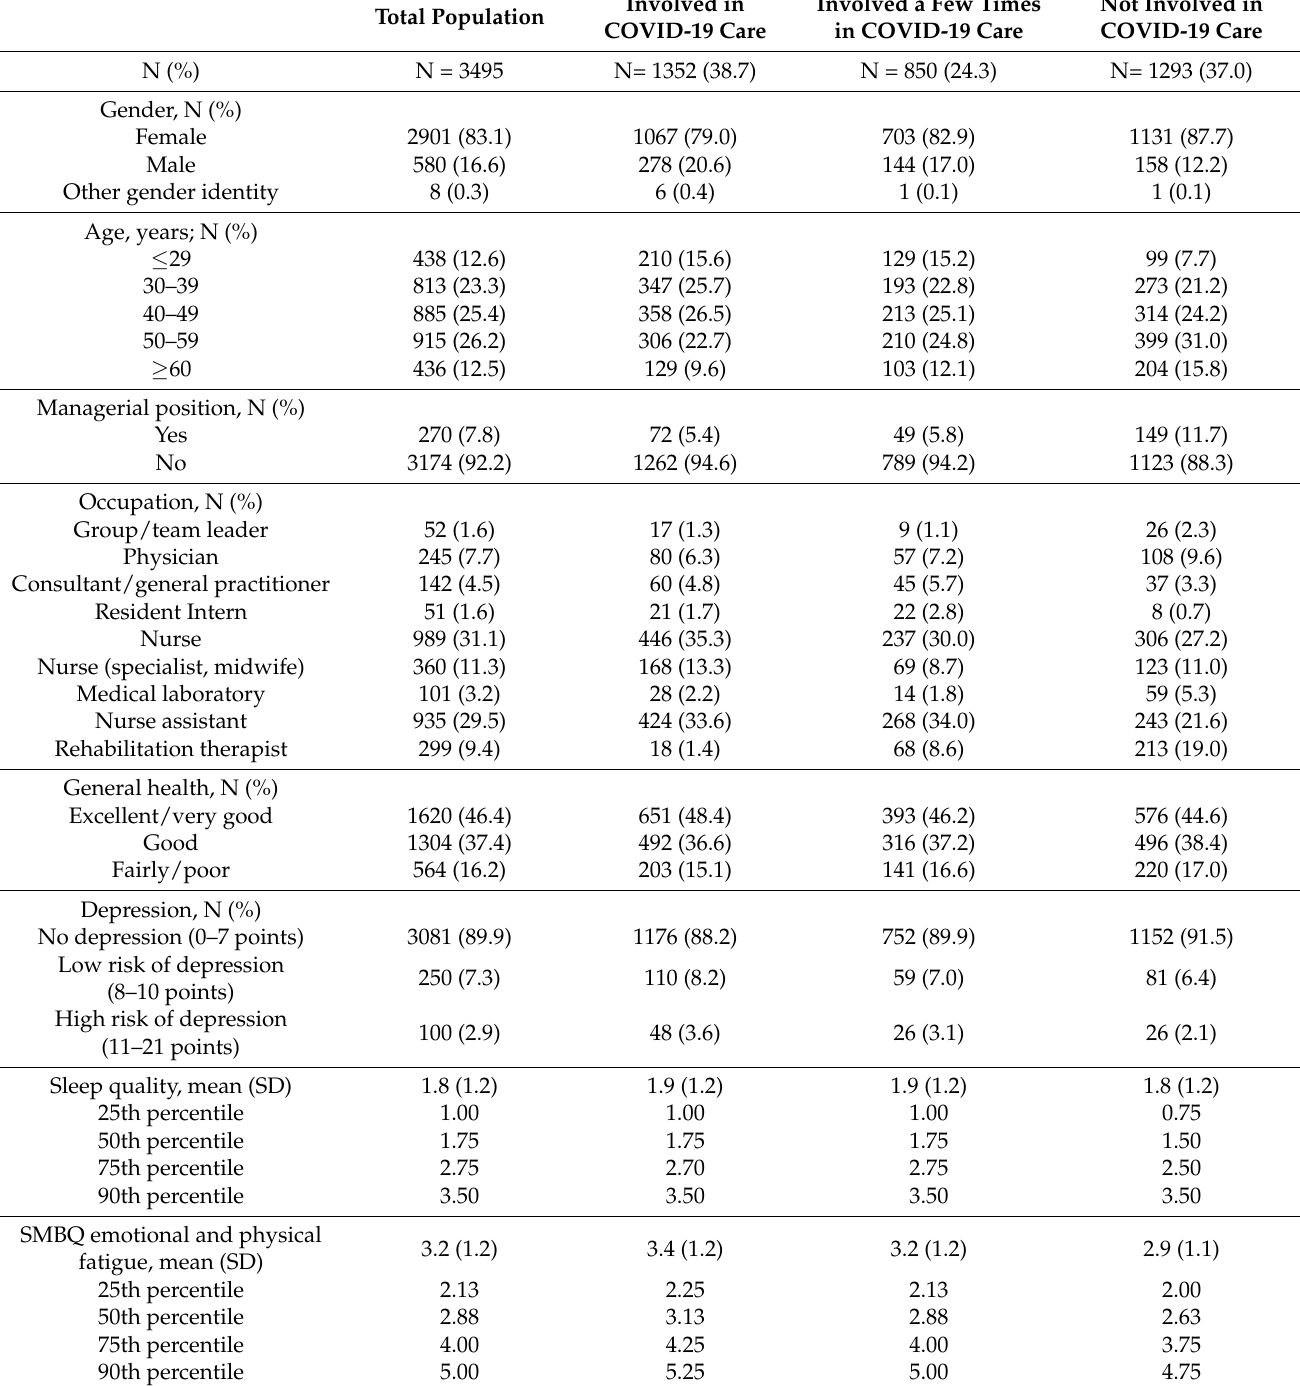
Table 1. Descriptive data for the total study population and employees working in COVID-19